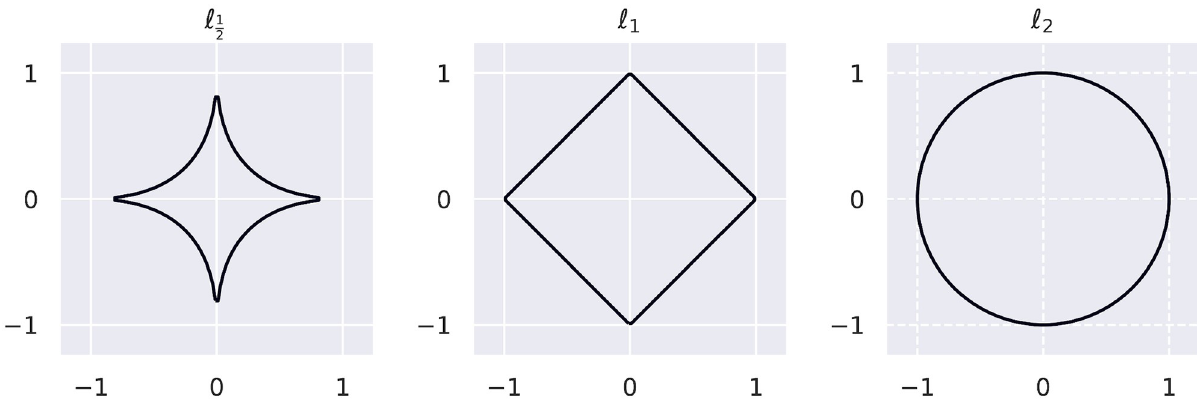
Fig 8. Combining scores. The set of points ( x , y )such that ℓ p ( x , y ) = 1, for three different values of p . This shows the form of the iso-lines of scores using function for different values of p to combine the the ℓ p